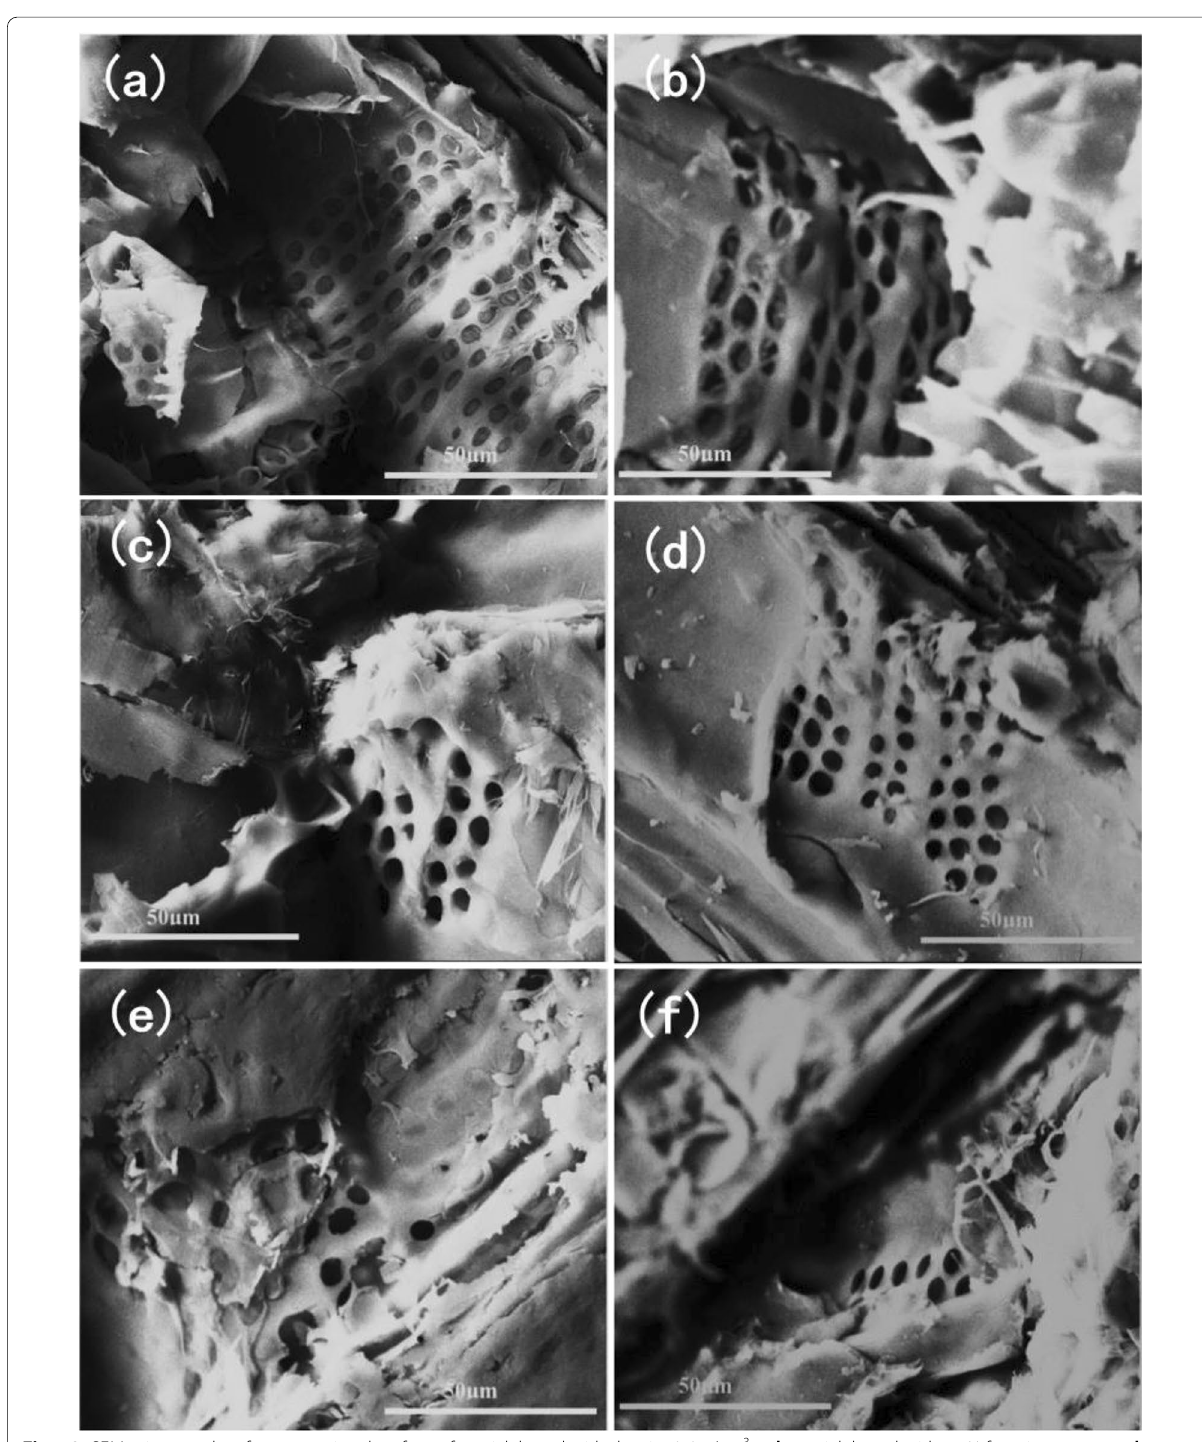
Fig. 10 SEM micrographs of cross-sectional surface of particleboard with density 0.6 g/cm 3 : a , b particleboard with 1.4% foaming agent, c , d particleboard with 1.2% foaming agent, e , f particleboard with 1.0% foaming